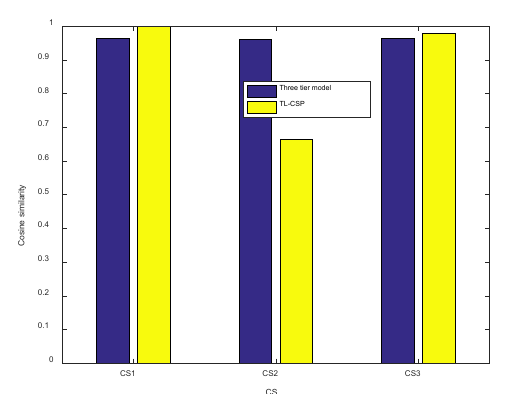
Fig .9 . Pearson correlation coefficient computation